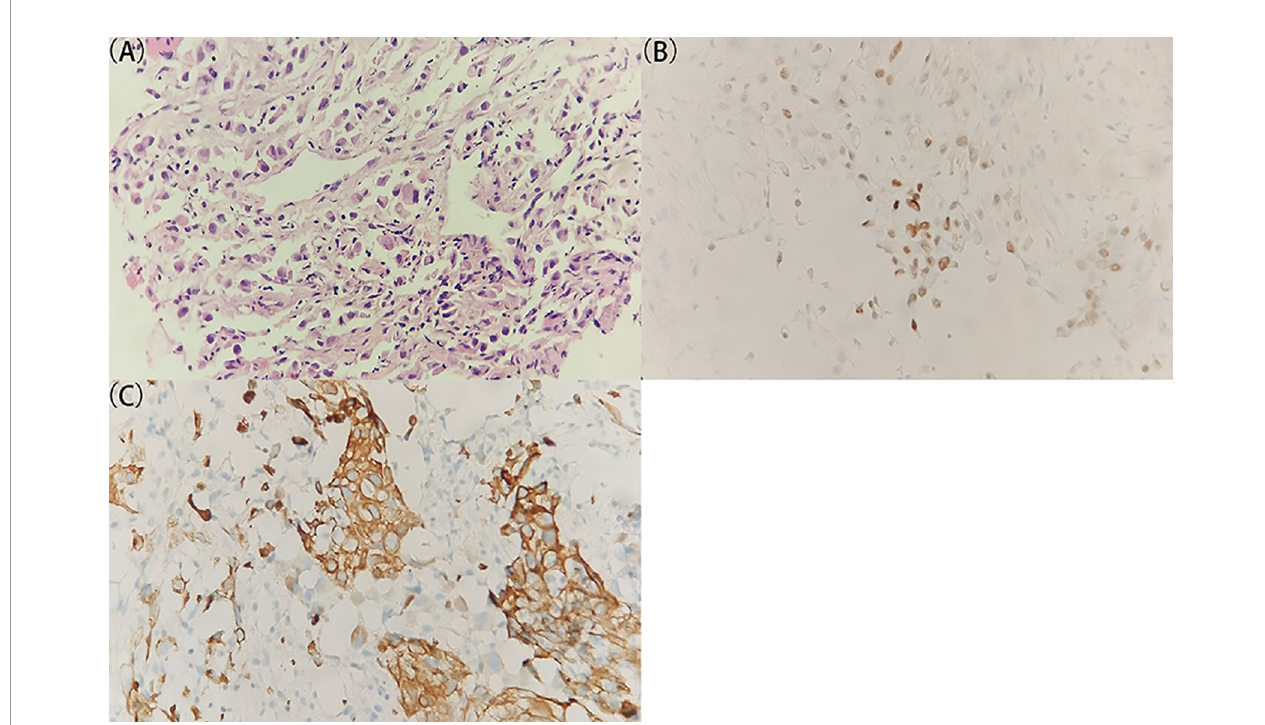
FIGURE 1 | Histological and immunohistochemical examination of the specimen from the right lymph lesion. (A) A representative image of the tumor specimen with H&E staining. The original tissue specimen and an H&E staining image with ×40 original magni fi cation are provided in Supplementary Figure S2 . (B, C) Representative images of immunohistochemical staining for (B) TTF-1 and (C) CK7 which demonstrate positive results. All images are ×400 original magni fi cation. The immunohistochemical results indicate a great probability of metastatic adenocarcinoma for the lymph